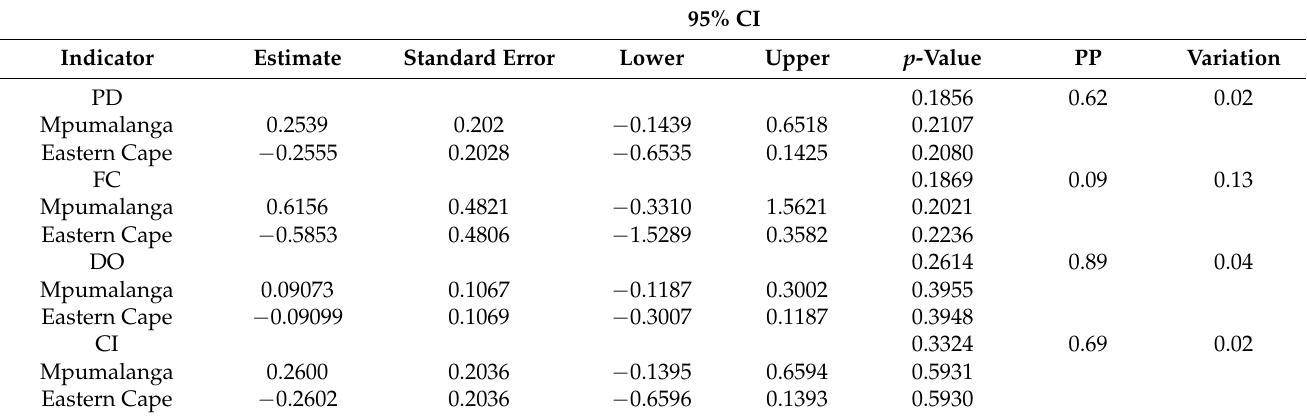
cattle herds at provincial level (Mpumalanga and Eastern